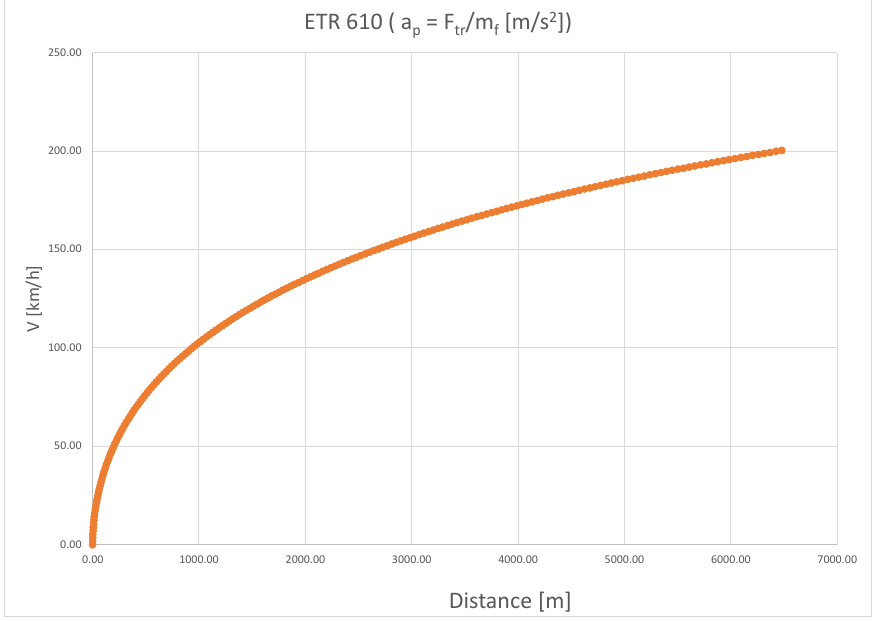
Figure 2. Acceleration characteristics of the ETR610 (ED250) train.